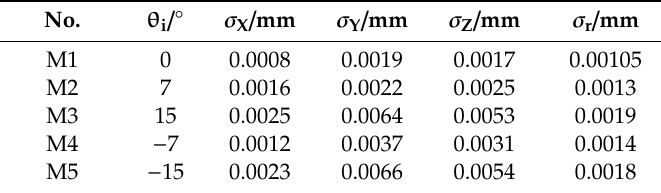
Table 2. Results o f the analysis of the angle measurement of the laser tracker. Table 2. Results of the analysis of the angle measurement of the laser